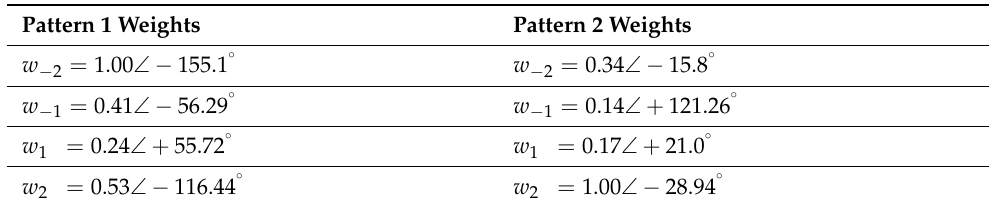
Table A4. Array weights of the conformal antenna on the wedge-shaped surface with θ b = 45 ◦ with coupling using